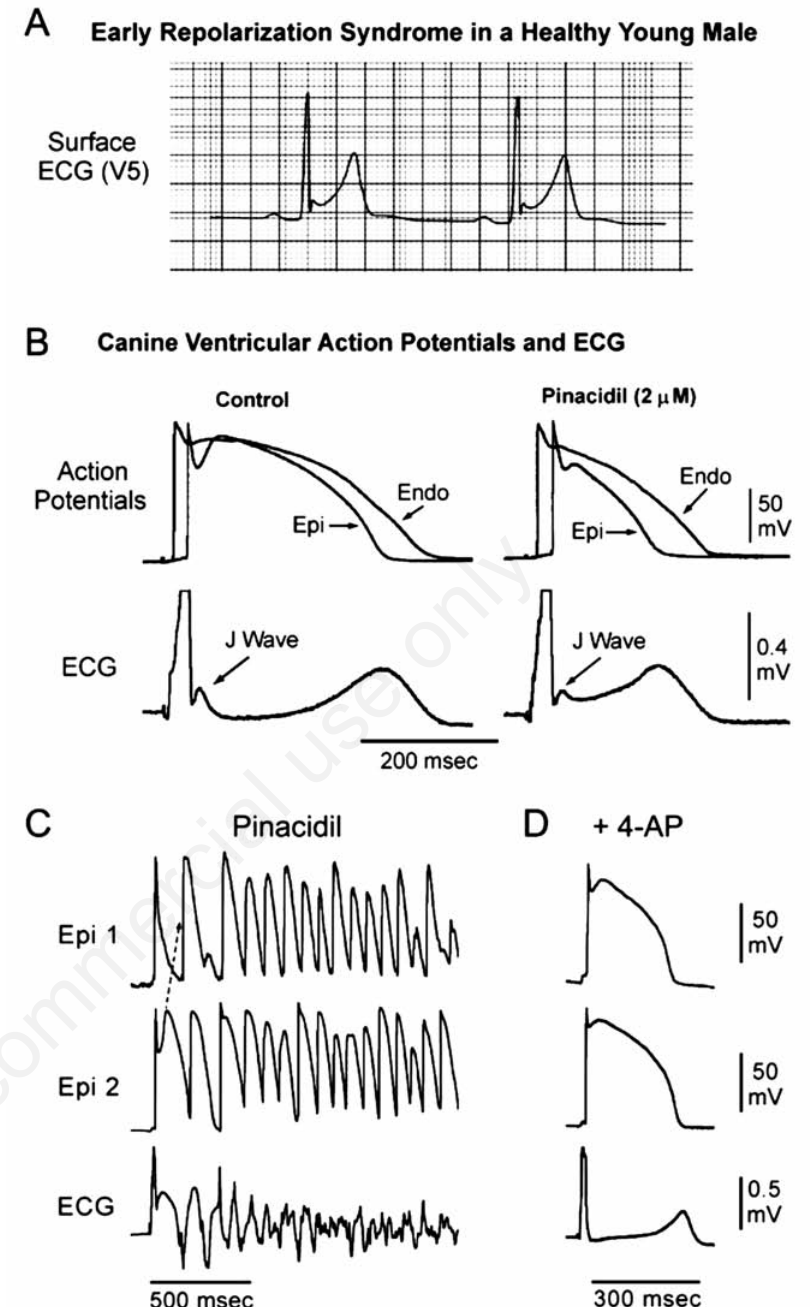
Figure 3. Cellular basis for the early repolarization syndrome. A) Surface electrocardiogram (ECG) (lead V5) recorded from a 17-year-old healthy African American male. Note the pres- ence of a small J wave and marked ST segment elevation. B) Simultaneous recording of transmembrane action potentials from epicardial (Epi) and endocardial (Endo) regions and a transmural ECG in an isolated arterially perfused canine left ventricular wedge. A J wave in the transmural ECG is manifest due to the presence of an action potential notch in epi- cardium but not endocardium. Pinacidil (2 mM), an ATP-sensitive potassium channel open- er, causes depression of the action potential dome in epicardium, resulting in ST segment elevation in the ECG resembling the early repolarization syndrome. Reprinted from Yan et al. 48 with permission. C) I activation in the canine right ventricular wedge preparation K-ATP using 2.5 uM pinacidil produces heterogeneous loss of the AP dome in epicardium, result- ing in ST segment elevation, phase 2 reentry and ventricular tachycardia and fibrillation (VT/VF) (Brugada syndrome phenotype). D) The I blocker, 4-aminopyridine (4-AP), to restored the epicardial action potential (AP) dome, reduced both transmural and epicardial dispersion of repolarization, normalized the ST segment and prevented phase 2 reentry and VT/VF in the continued presence of pinacidil (modified from Di Diego et al. , 2004 101 , and Antzelevitch and Yan, 2010 9 with